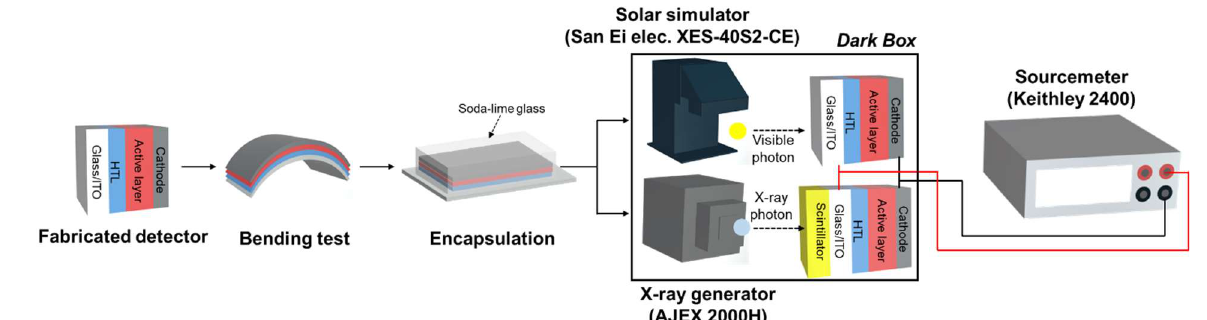
Figure 3. Experimental set-up of measuring the photodetector parameters of the scintillator decou- pled detector, and the X-ray parameters of the scintillator coupled